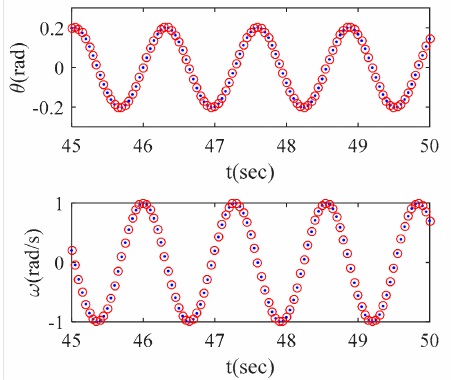
Figure 9. The difference calculation results under reduced attitude.